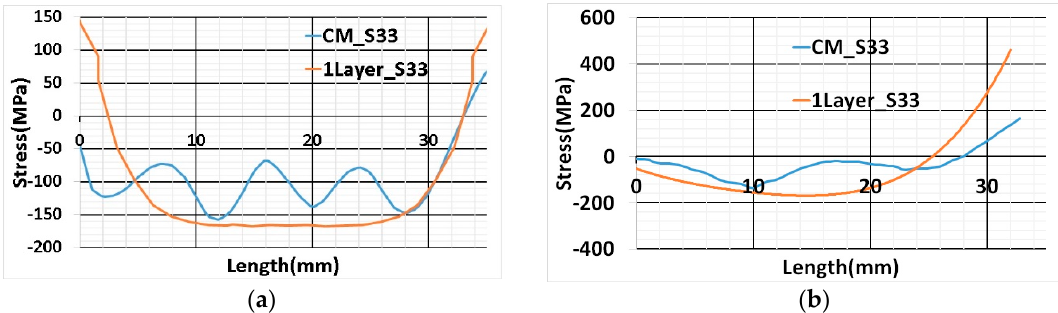
Figure 20. ( a ) Path-1 position and direction start from the left edge of the cube marked as (0), ends at the right edge (35); ( b ) Path-2 position and direction start from the surface of the base plate marked as (0) ends on the surface of the printed cube, i.e., 35mm height marked as (35).